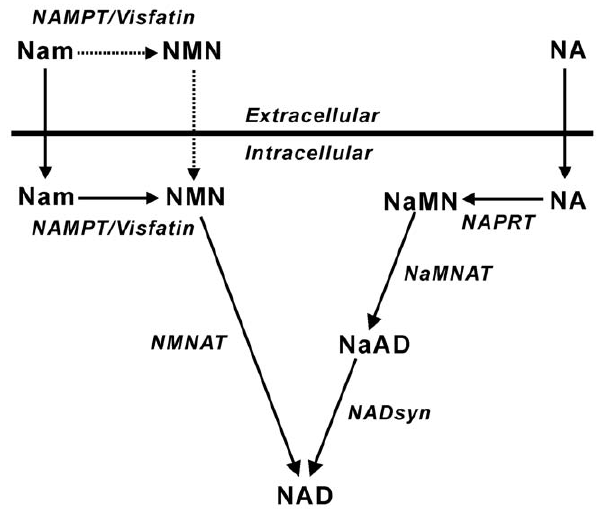
Figure 1. Metabolic pathways of the salvage NAD synthesis. NaAD, NA adenine dinucleotide; NMNAT , NMN adenylyltransferase; NaMNAT , NaMN adenylyltransferase; NADsyn , NAD synthetase. Broken arrows indicate the possible extracellular pathway in NAD